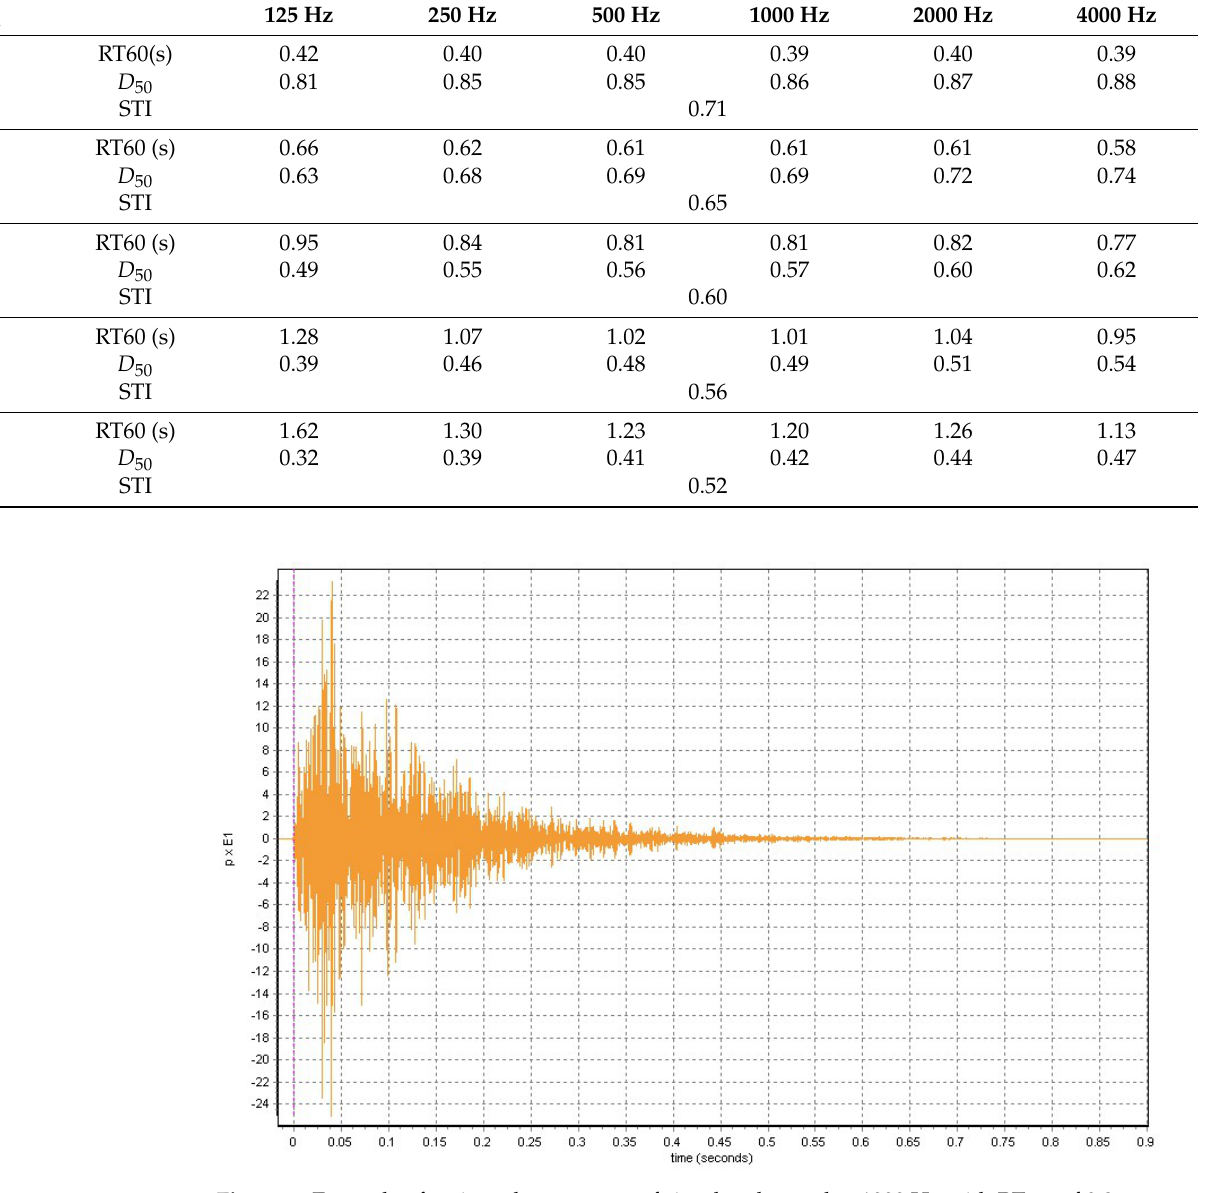
Figure 3. Example of an impulse response of simulated sound at 1000 Hz with RT sim of 0.8 s.